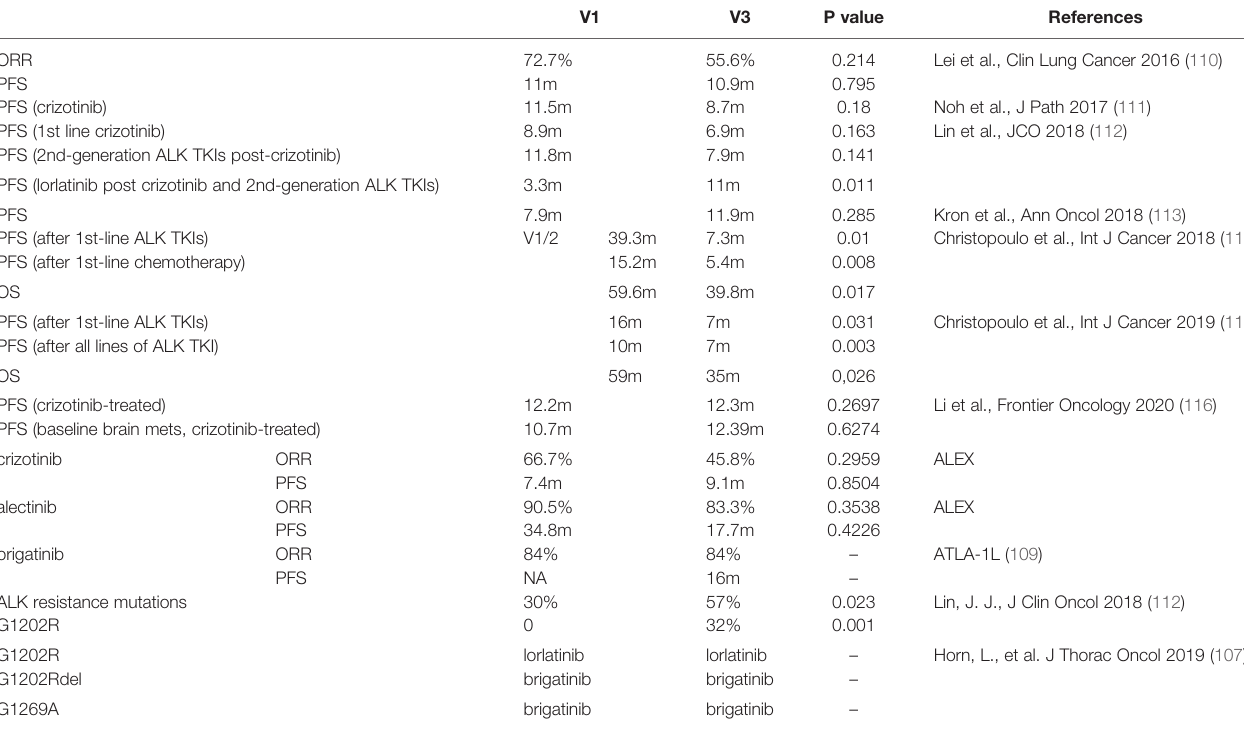
TABLE 4 | List of retrospective analyses comparing clinical ef fi cacy of EML4-ALK variants and ORR and PFS in prospective phase 3 trial of fi rst-line ALK TKIs. V1